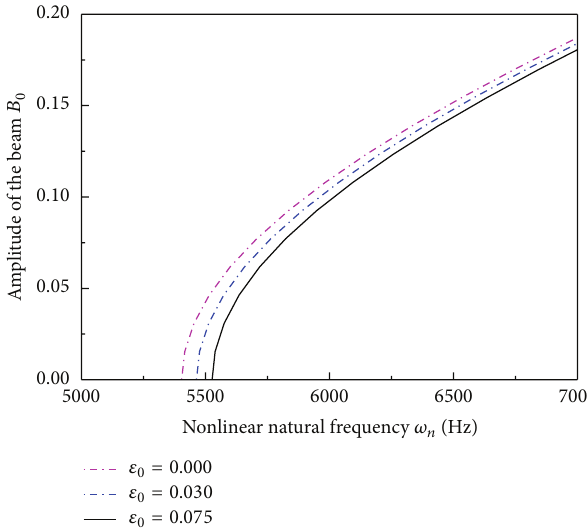
Figure10:Variationofthenonlinearnaturalfrequencywiththefree vibration amplitude 𝐵 0 for different 𝜀 0 ( 𝑉 𝑠 = 0.005 , T = 60 ∘ C, and 𝐿/ℎ = 10